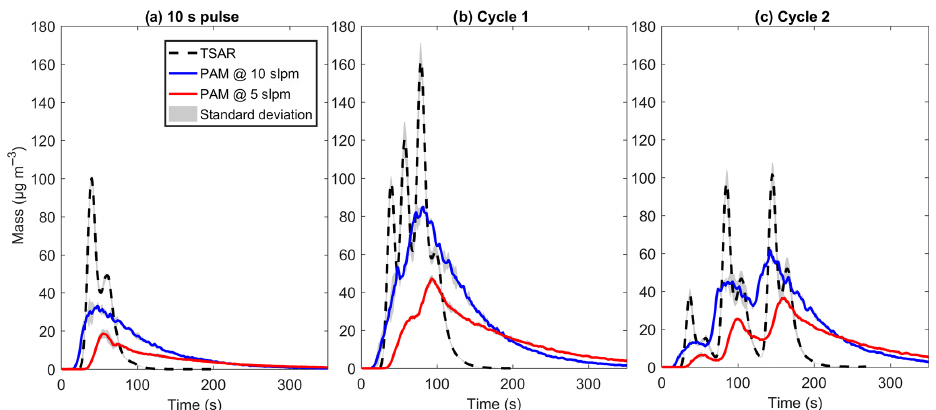
Figure 13. The mass produced from SOA formation of toluene pulses in TSAR at 5slpm flow rate and in PAM at 5 and 10slpm flow rates. The shaded area shows the standard deviation. The figures show the mass formation of a single pulse (a) as well as cycle 1 (b) and cycle 2 (c) , which are both comprised of three adjacent pulses.